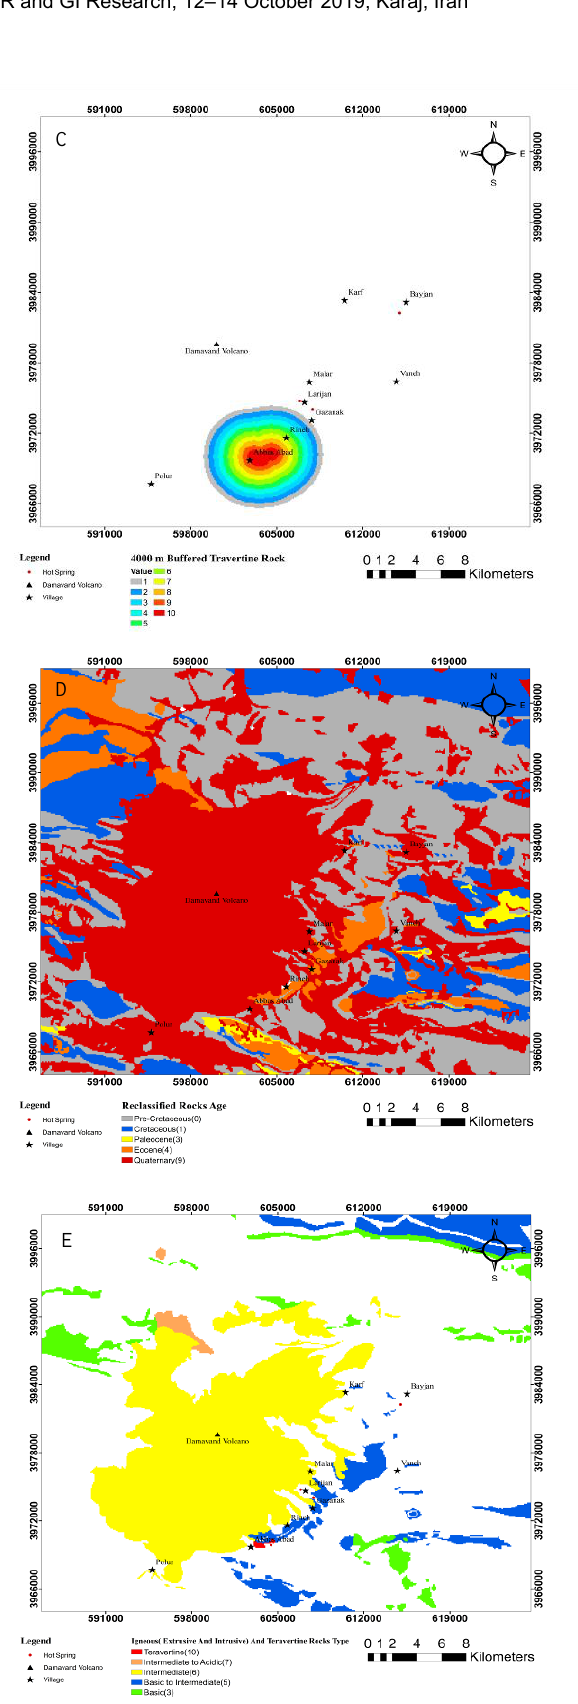
Figure 2. Geology Factor Classified map A) Young intrusive bodies. B) Young volcanic rocks. C) Travertine sedimentary rock. D) Distribution Rocks based on age. E) Distribution